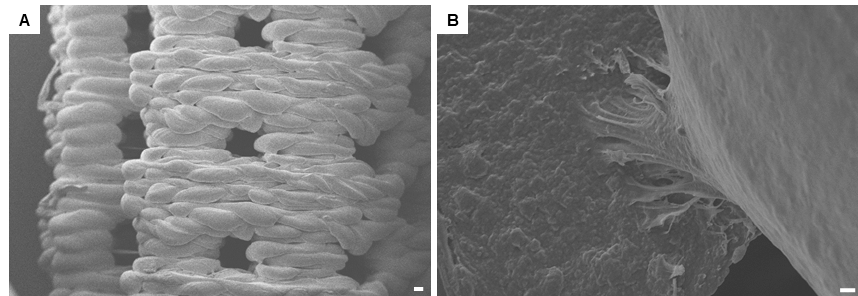
Figure 2. Scanning electron microscope (SEM) detection. ( A ) three-dimensional scaffold design observed at low magnification (50×). The scale bar represents 100 μ m; ( B ) at high magnification (1000×), the cellular bridge is clearly visible. The scale bar represents 10 μ m.